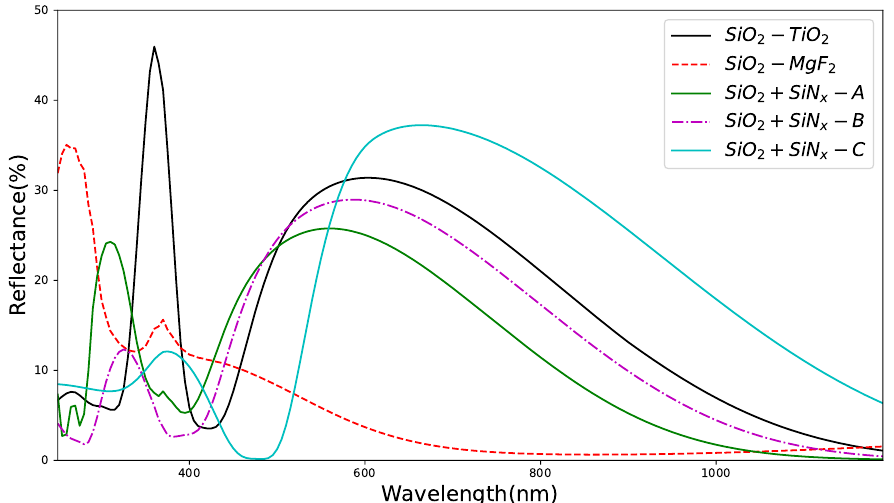
Figure 4. Reflectance spectra as a function of wavelength for some double-layer anti-reflection coating. Based on Equation (11) the optical thickness of the DLARC layers was optimized to obtain a minimum reflectance. Figure 5 shows the reflectance spectra of the DLARC layers. The inset of Figure 6 shows the thickness variation for both SiO 2 and the capping layer. The SiO 2 layer capped with MgF and SiN x − C ( n = 2.71 ) showed a reflectance of 2 2.2% whereas for the TiO 2 , SiN x − A and SiN x − B layers the reflectance was 0.34%, 0.11% and 0.19% respectively with the thickness of ∼ 60–70 nm. From the optimized reflectance curves, we can observe that when the reflectivity is substantially mitigated at the front surface, the gain in efficiency of the solar cell. Table 3 represents the I − V parameters as well as the calculated blue loss and ARC loss with optimized DLARC layers.